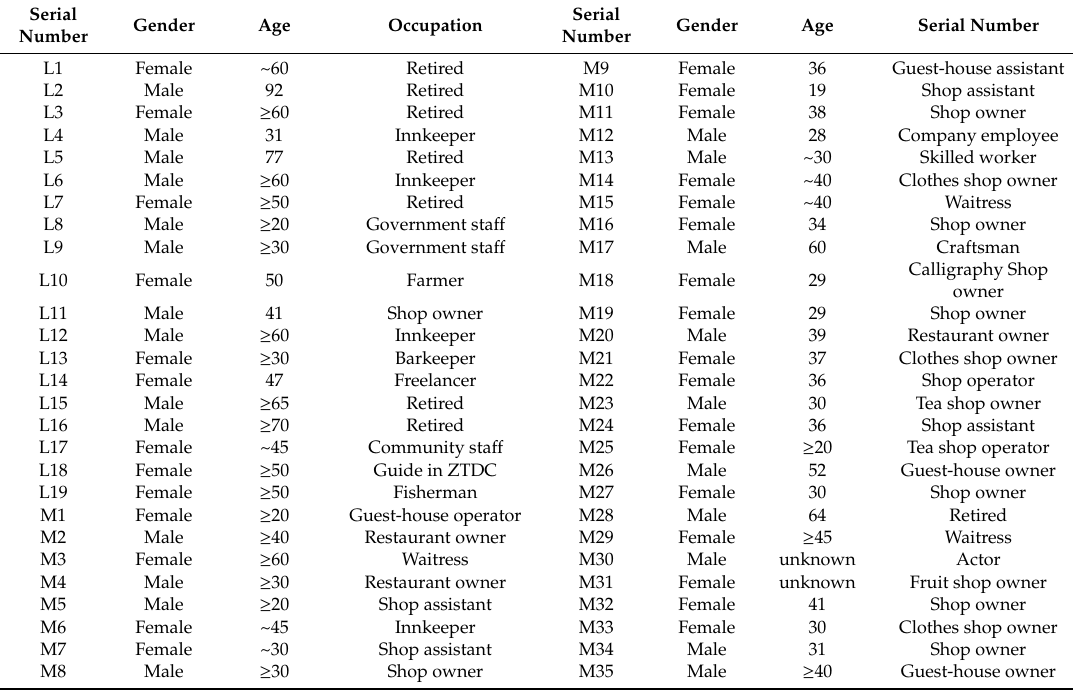
Table 1. Demographic characteristics of